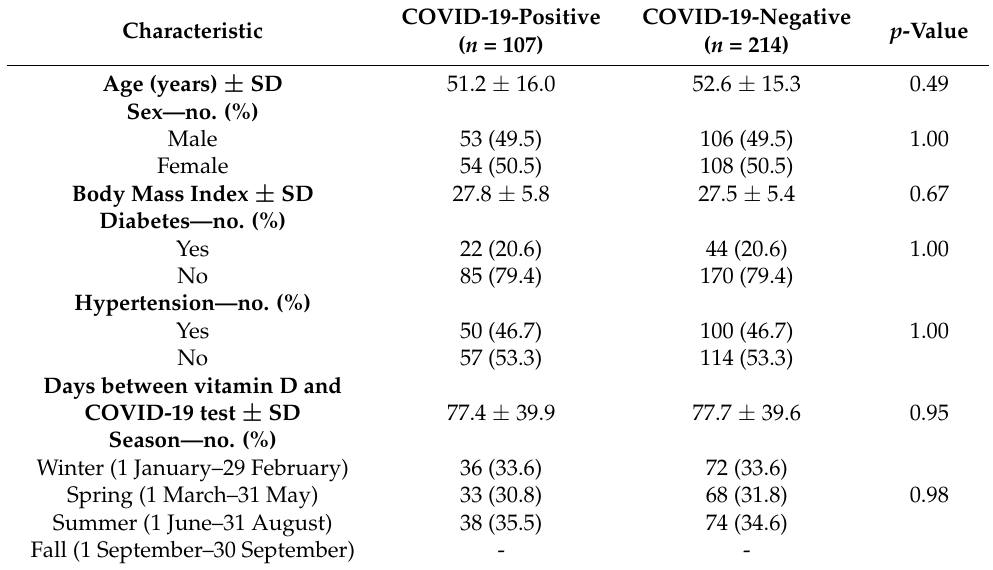
Table 1. Characteristics of the COVID-19 study population and controls: serum 25(OH)D measured before COVID-19